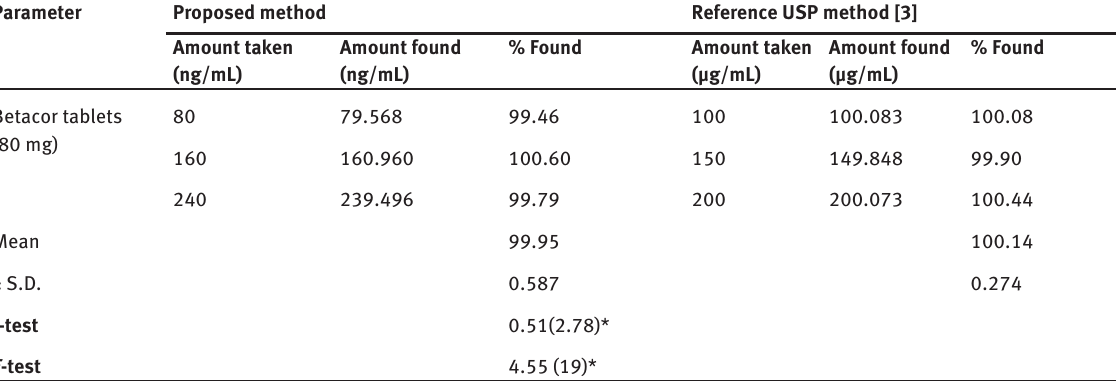
Table 4: Assay results for the determination of SOT in its tablet dosage form by the proposed method and the reference USP method.